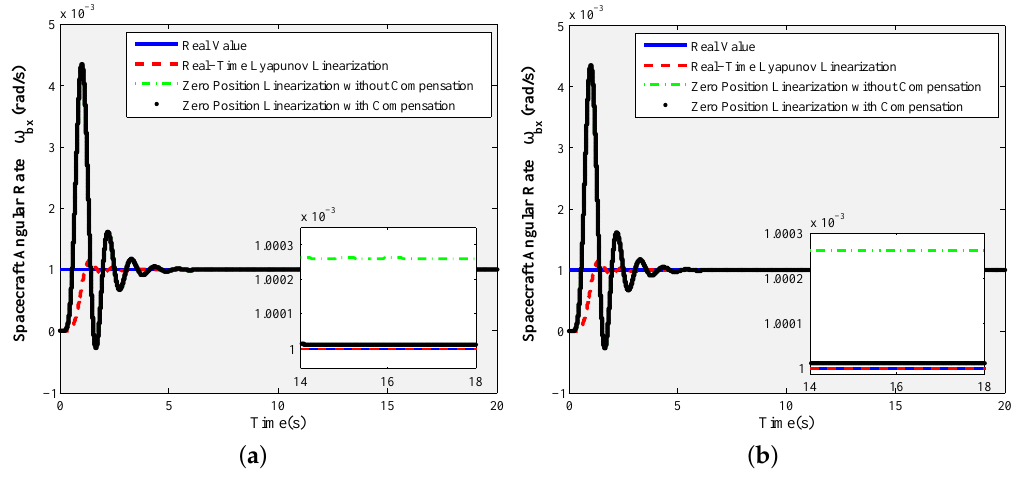
Figure 6. Static measurement φ xd = 0.1 ◦ , φ yd = 0 ◦ , constant motor spin rate ˙ θ zd = 157.04 rad/s: ( a ) X-axis angular rate sensing of the spacecraft ω bx ; ( b ) Y-axis angular rate sensing of the spacecraft ω by